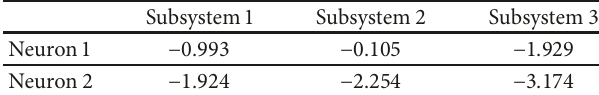
Table 2: Calculation results of inequality (9).